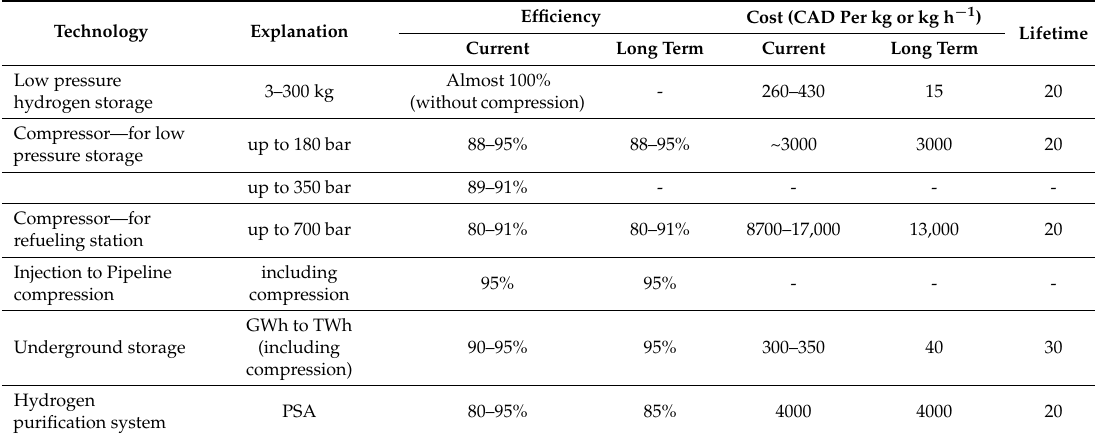
Technical, and economic data for hydrogen storage, compression and purification technologies